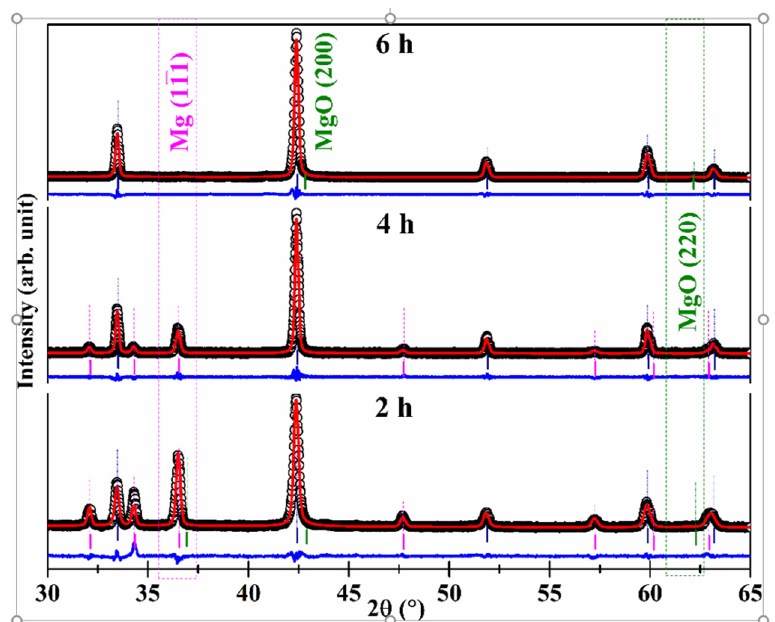
Figure 1. Representative XRD patterns of MgB 2 samples obtained with Mg:B = 1.4:2 at T = 800 °C and corresponding to increasing processing durations of 2 h (sample MBNB16), 4 h (MBNB04) and 6 h (MBNB06), respectively. Black void circles represent experimental data points, red solid lines are the best fits, and solid blue lines are the corresponding residuals. The expected positions of the peaks are labeled by vertical solid ticks in magenta (Mg), olive (MgO), and navy (MgB 2 ) colors, respectively. Expected positions of peaks Mg ( 111 ) and MgO (220) are enclosed in magenta and olive dashed boxes to guide the eye. Table 1. Sample synthesis parameters (stoichiometric ratio Mg:B, temperature T , dwell time t d ) and corresponding weight percentage fractions (wt. %) of the several crystalline phases (Mg 2 B 25, MgB 2, Mg, and MgO) detected in the samples. The first row corresponds to sample names. Final values of R wp , R exp, and GoF χ 2 = R wp / R exp are also reported.